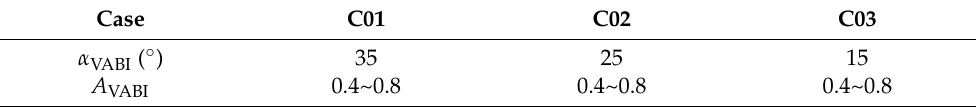
Figure 16. Schematic of the VABI test facility: ( a ) structure of the test rig; ( b ) the orifice control valve; ( c ) the replaceable inner bypass duct. Table 4. Variation range of the VABI test rig. Table 4. Variation range of the VABI test rig.